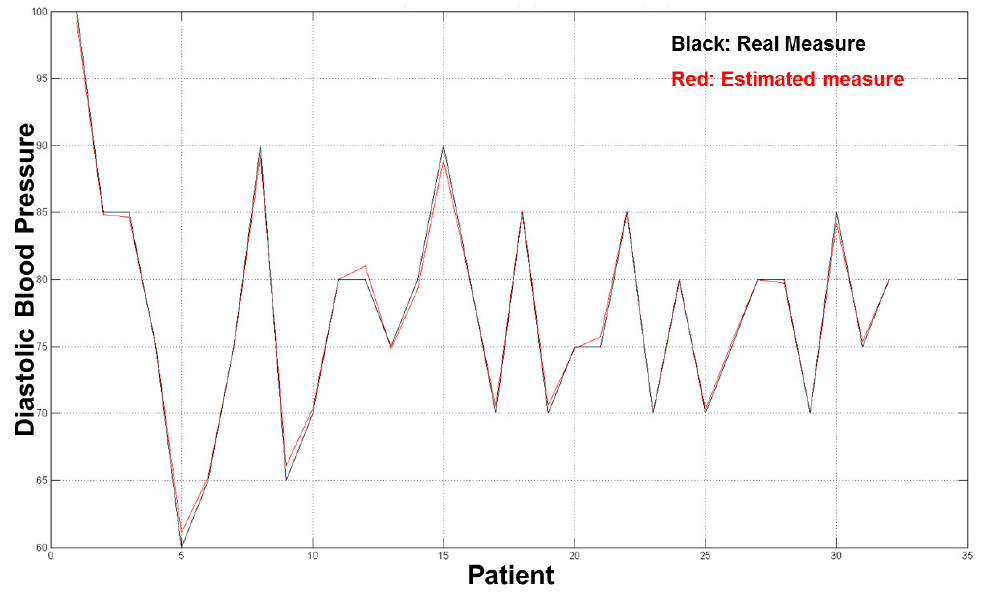
Figure 11. DBP estimation performance diagram.